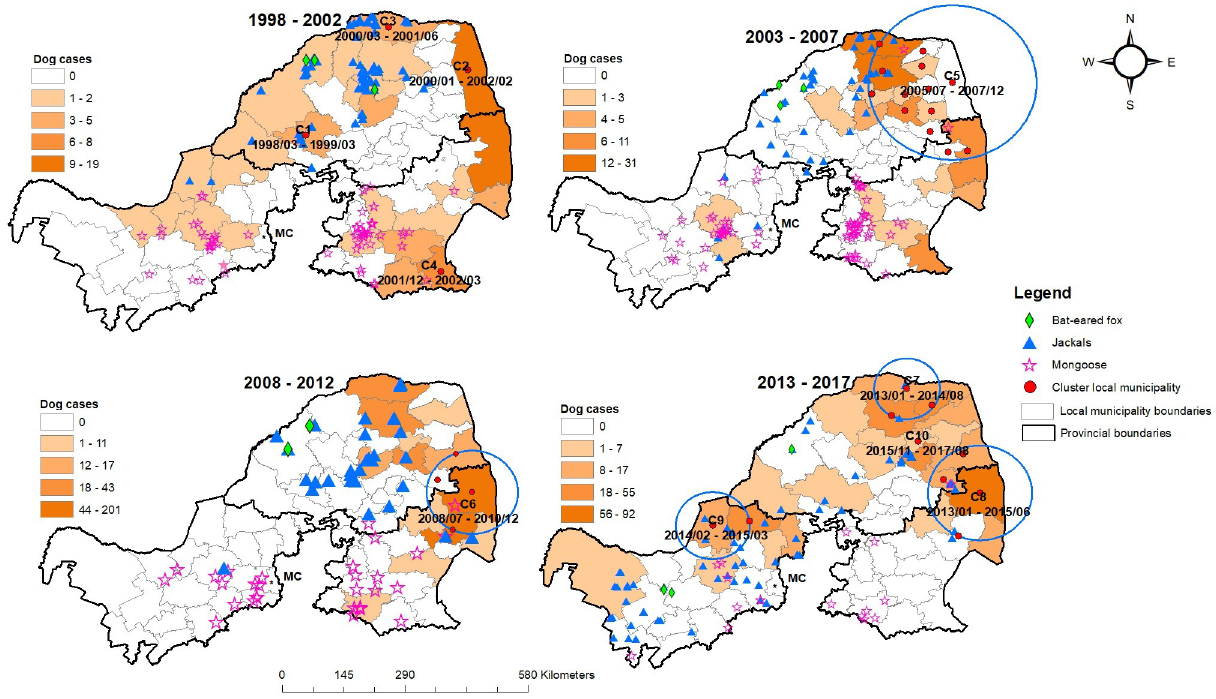
Fig 5. Spatio-temporal clusters of dog rabies in each time period and spatial distributions of wildlife rabies cases indicated on choropleth maps of dog rabies in four time periods between 1998 and 2017. Red dots indicate local municipalities affected by spatio-temporal clusters. MC denotes a local municipality of Gauteng Province, and was excluded from this study. < https://dataportal-mdb-sa.opendata.arcgis.com/ > .